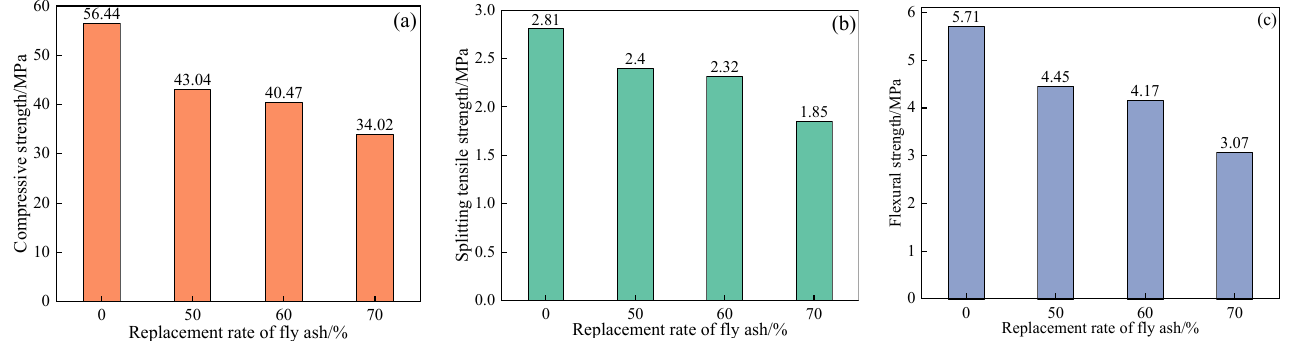
Figure 5. The mechanical properties of SCC with high level fly ash at 28 d age: ( a ) compressive strength; ( b ) splitting tensile strength; ( c ) flexural strength.